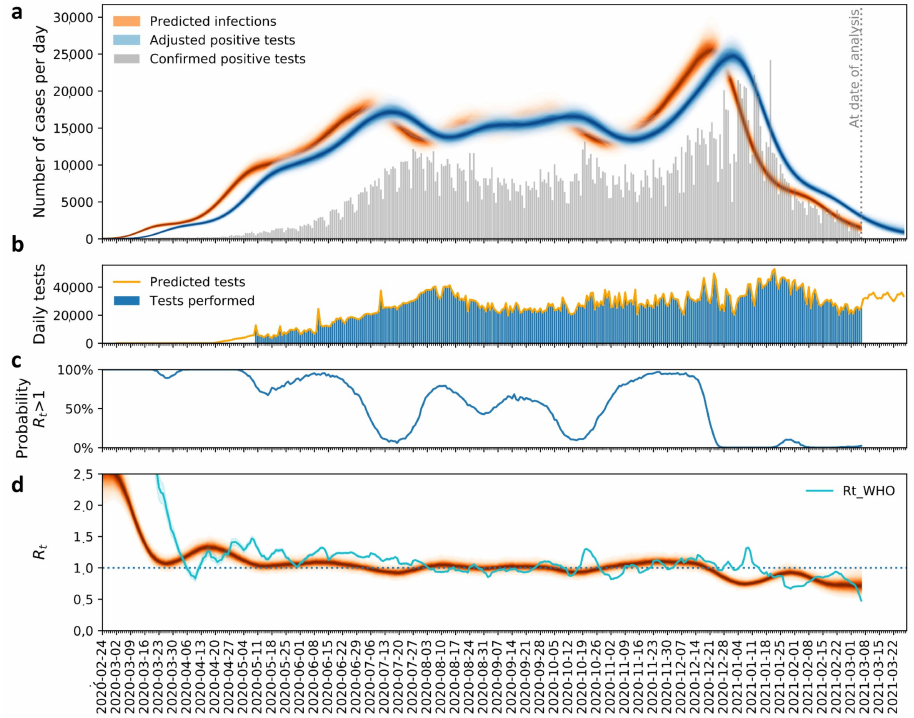
Figure 4. Epidemic model results. ( a ) Positive tests and infections: the bars represent the positive tests per day. The blue line corresponds to the positive tests corrected by the model, which adjusts for the number of daily tests. The red line is the infection events (cases) that will later become positive tests. The difference between the bars and the blue line corresponds to the positive tests inferred by the model that was not able to diagnose. The model has errors, so the blue and red lines are blurred. This graph predicts the evolution at 21 days. ( b ) Daily test: the blue bars correspond to the number of total tests performed. The yellow line are the tests that the model predicts will be performed in the future. ( c ) Probability Rt > 1: the blue line corresponds to the probability that the Rt is greater than 1. ( d ) Rt : Here, Rt is plotted for each point in time. The model has errors, so the red line is blurred. The Rt estimation from the use of the WHO model (EpiEstim) is also plotted in light